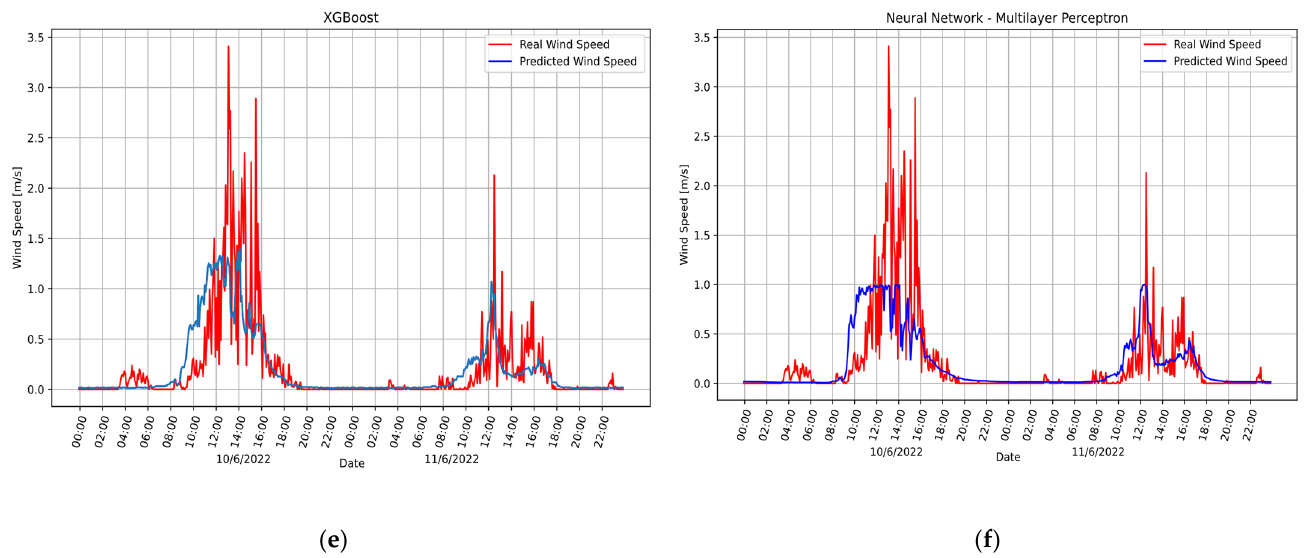
Figure 8. Techniques for wind speed forecast: ( a ) Multiple linear regression, ( b ) Polynomial regression, ( c ) Decision tree, ( d ) Random forest, ( e ) XGboost, ( f ) Multilayer perceptron neural network.